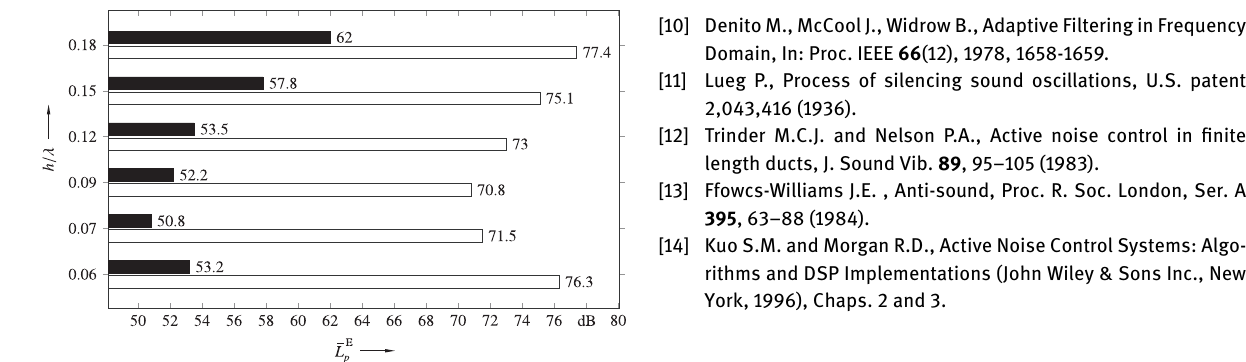
Figure 15: Mean primary (white) and residual (black) sound pressure